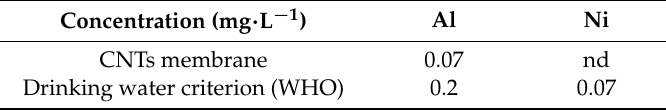
Figure 10. E. coli ( a ) and S. aureus ( b ) survival after exposure to mullite ceramic substrate (control) and mullite-CNT composite membrane. Table 1. Concentration of selected metal ions in the